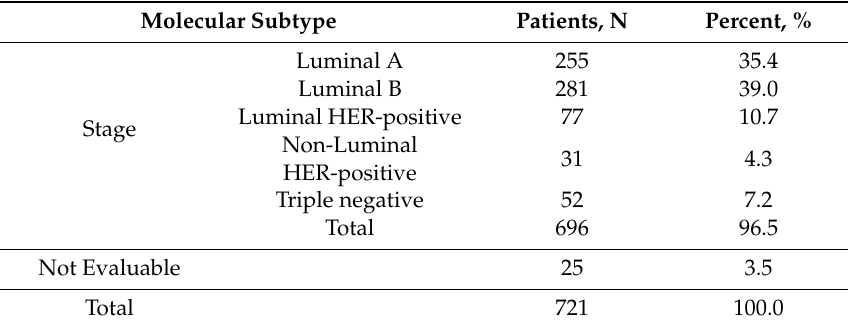
Table 7. Molecular subtypes of breast cancer.